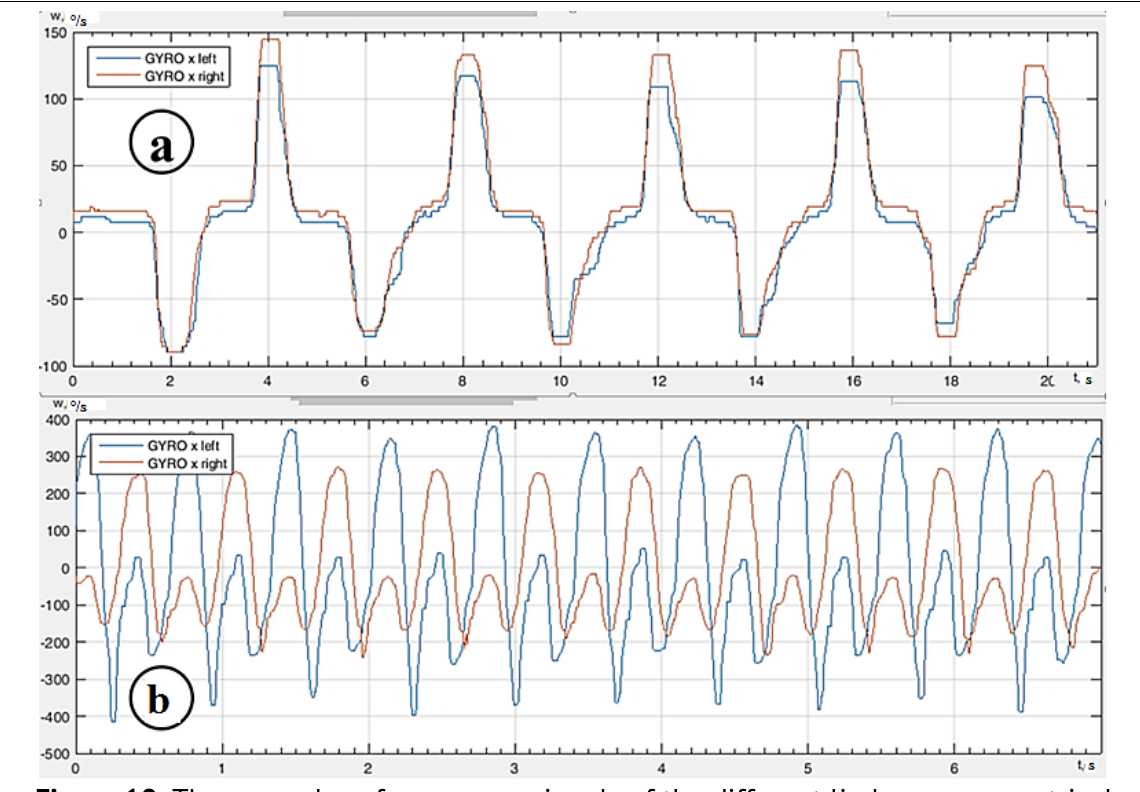
Figure 10 . The examples of gyroscope signals of the different limbs: a - symmetrical movement (bending of arms in elbow joints); b - asymmetrical movement (running).